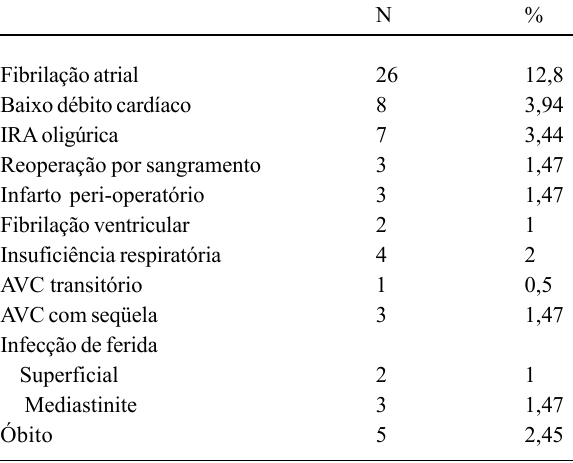
Tabela 2. Complicações